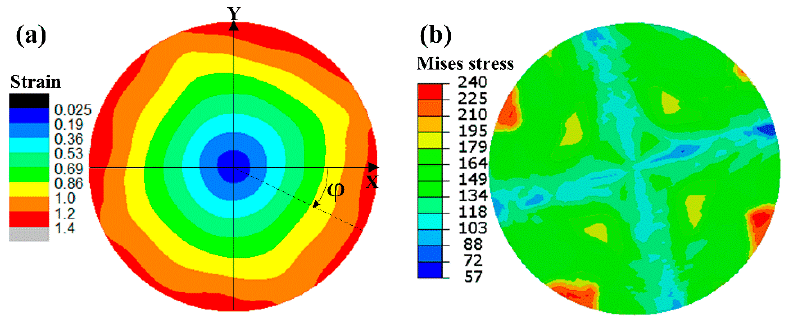
Figure 2. The distributions of ( a ) equivalent plastic strain and ( b ) Mises stress on the surfaces of (001) aluminum single crystal after N = 1/12 turn of HPT deformation.